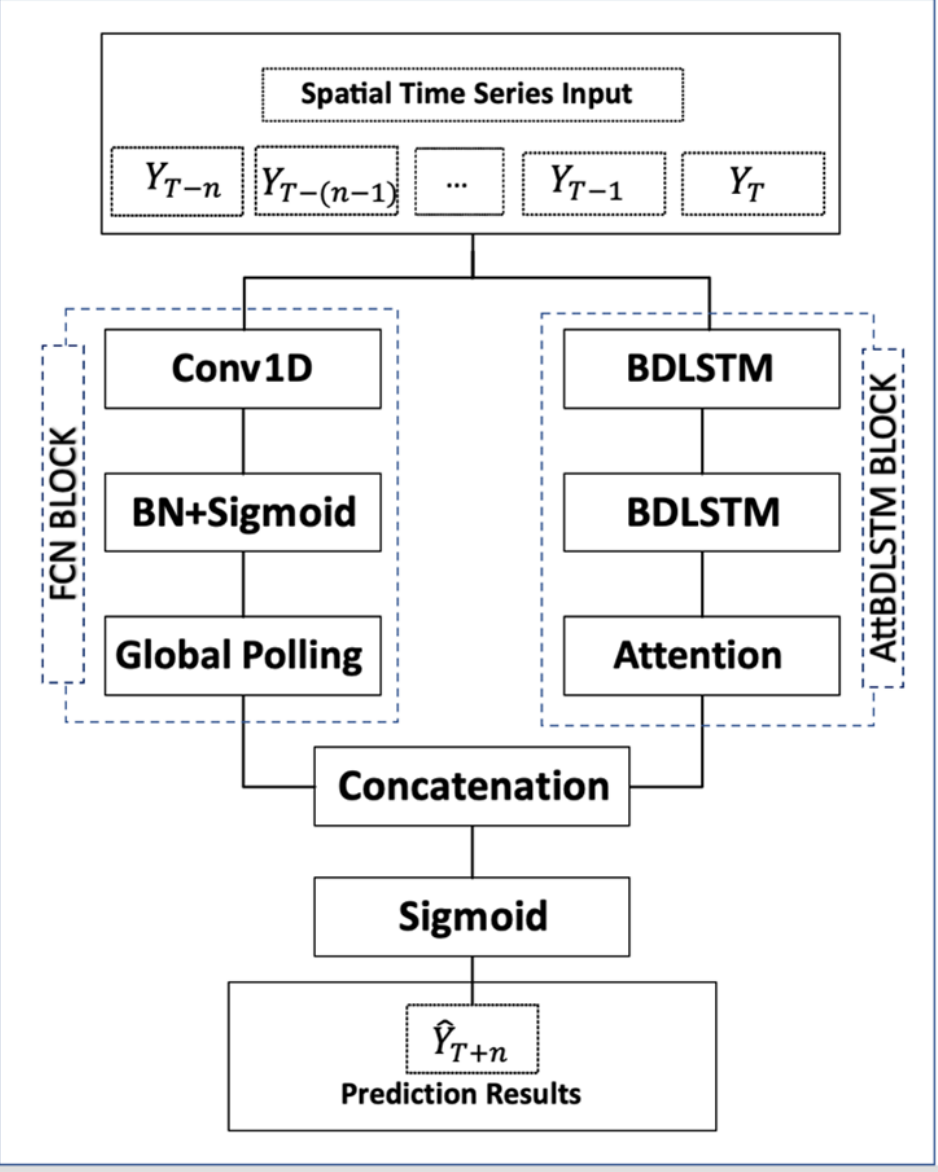
Figure 4. The proposed model